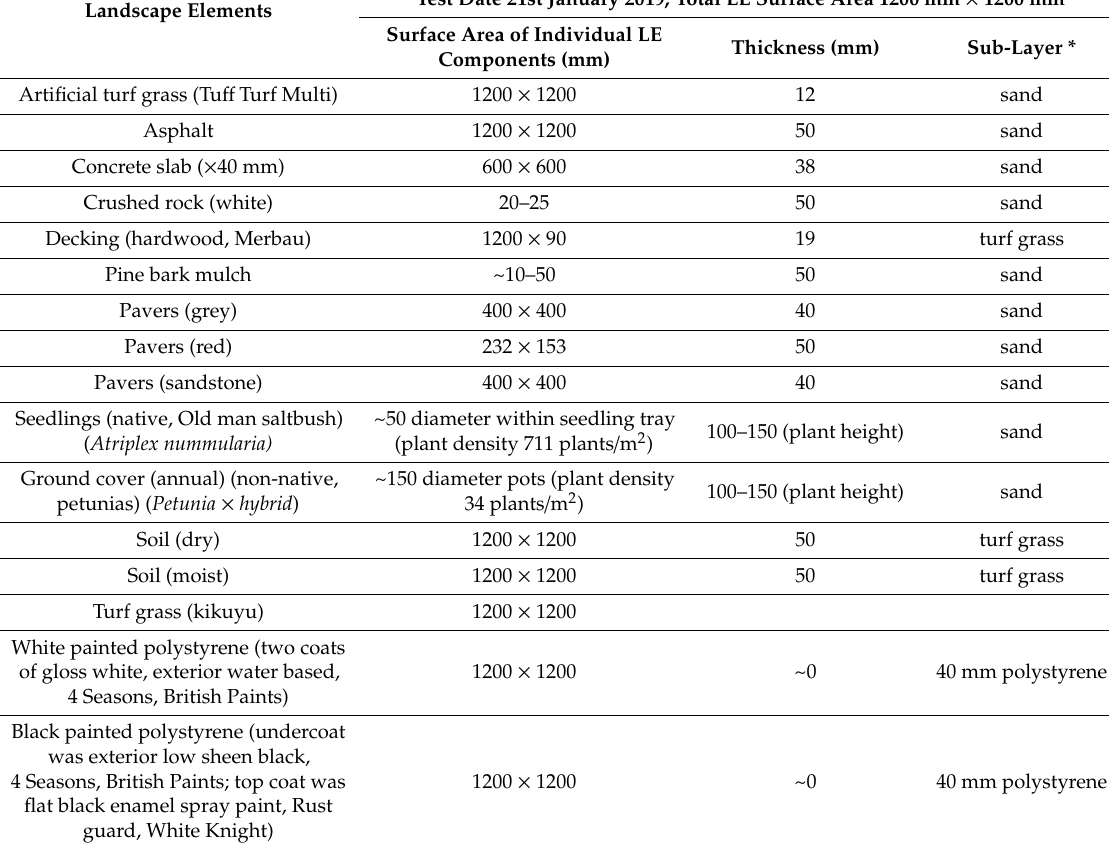
Table 2. Installation details of the larger landscape elements used in the phase 2 study design